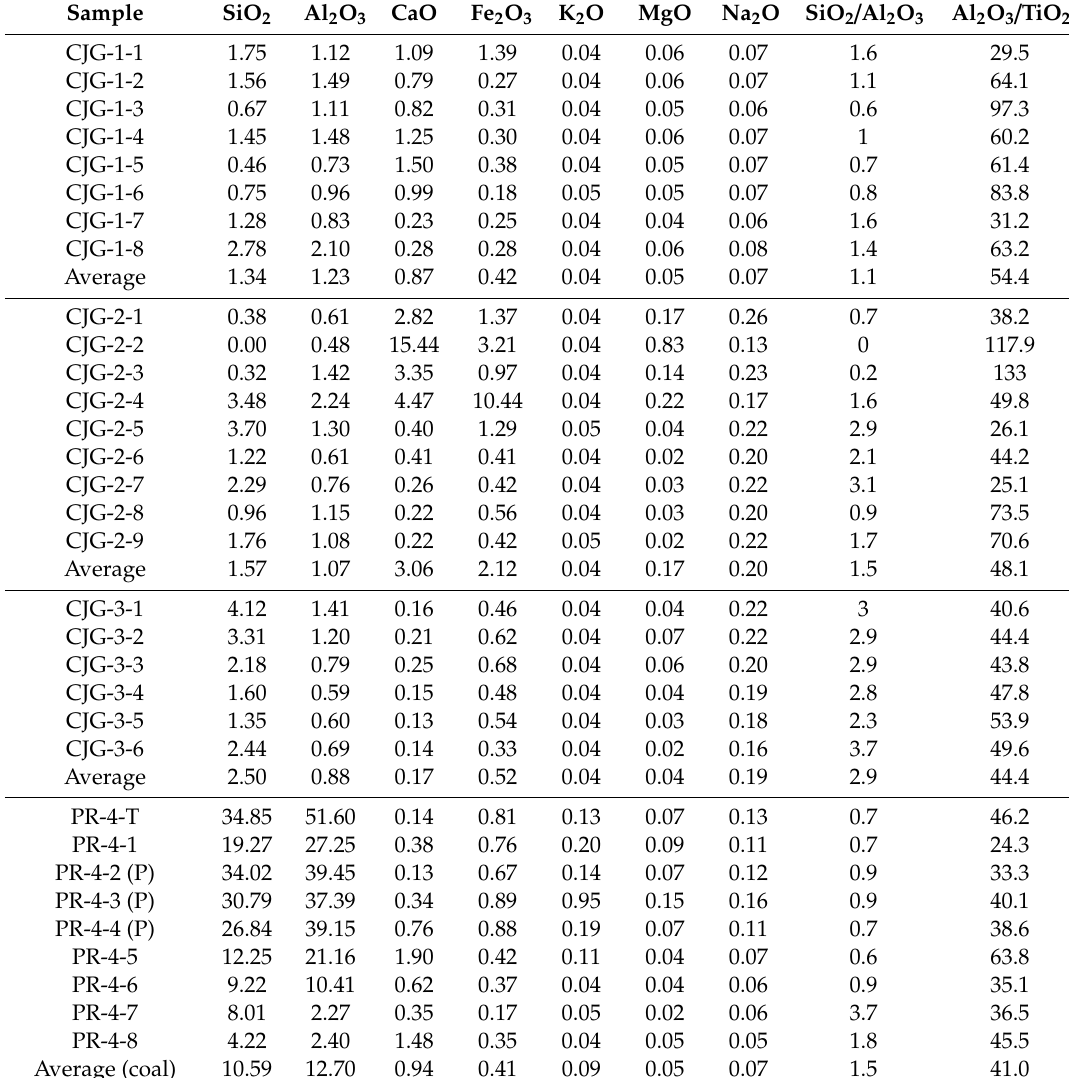
Table 3. Major elements (%, db) content and geochemical ratios in coal and non-coal samples from the two studied coal